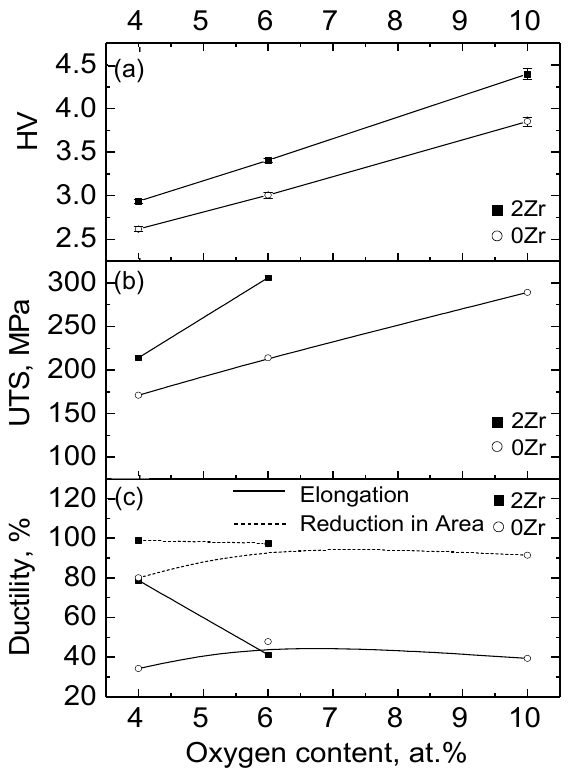
Figure 8. Effect of oxygen and zirconium contents on the mechanical properties: ( a ) Vickers-hardness (HV) at room temperature; ( b ) Ultimate tensile strength (UTS) and ( c ) tensile ductility at 750 °C. This means that HV will be increased by ~0.24 GPa on average for 2Zr-xO alloys and ~0.21 GPa on average for 0Zr-xO alloys as O content is increased by 1%. It indicates that Zr addition increases the strengthening effect of